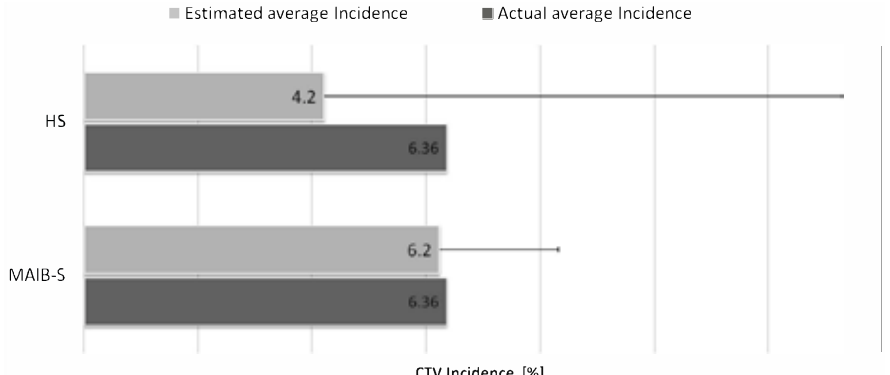
Figure 6. Mean Citrus tristeza virus (CTV) incidence in all eight groves assessed in this study, estimated by the Hierarchical Sampling method (HS) and the Mediterranean Agronomic Institute of Bari sampling method (MAIB-S), each compared to the actual incidence of CTV as estimated by testing of all trees in study by Direct Tissue Blot Immunoassay (DTBIA) method. The standard errors introduced by each method are shown.